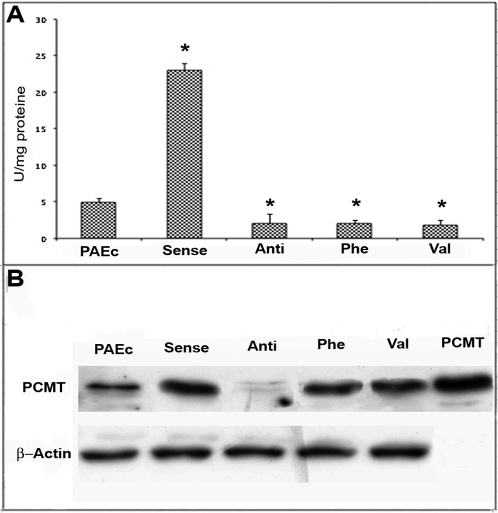
Characterization of PCMT plasmid constructs.Panel A) Plasmids were transfected into endothelial cells and 48 h later methyltransferase activity was assayed using a methanol diffusion assay in the presence of saturating concentrations of the methyl donor AdoMet and ovalbumin as a methyl accepting protein. Results are given as the mean of three experiments. Error bars indicate standard deviation; (*) refer to statistically significant differences (p<0.05), as evaluated by t-test. Panel B) Cells transfected were then processed for immunoblotting with PCMT antibody. The immunoblot was reprobed for actin as a loading control. The sample “PCMT” is authentic human recombinant enzyme as a positive control. PAEc = PAE transfected with void plasmid.